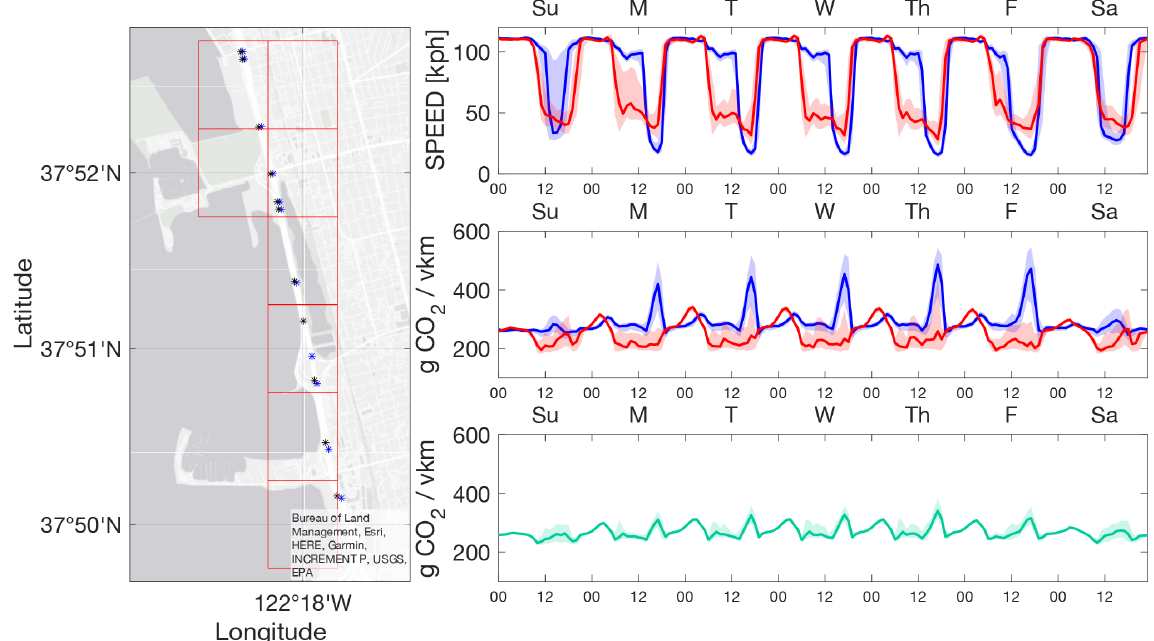
Figure 2. The left panel shows the ∼ 5km stretch over which we analyze grams of CO 2 per vehicle kilometer (vkm). Points show the location of PeMS stations, and squares show the pixels associated with BEACO 2 N-STILT output that we use for comparison for the 5km stretch. The top right panel presents the hourly average speed shown for two opposite (west in red, and east in blue) PeMS measurement stations for a typical week. The middle right panel presents the PeMS-EMFAC-derived emission rates calculated for two opposite (west in red, and east in blue) PeMS measurement stations for a typical week. The bottom right panel presents the aggregate PeMS-EMFAC-derived estimated emission rates from the two directions of traffic for a typical week for this highway